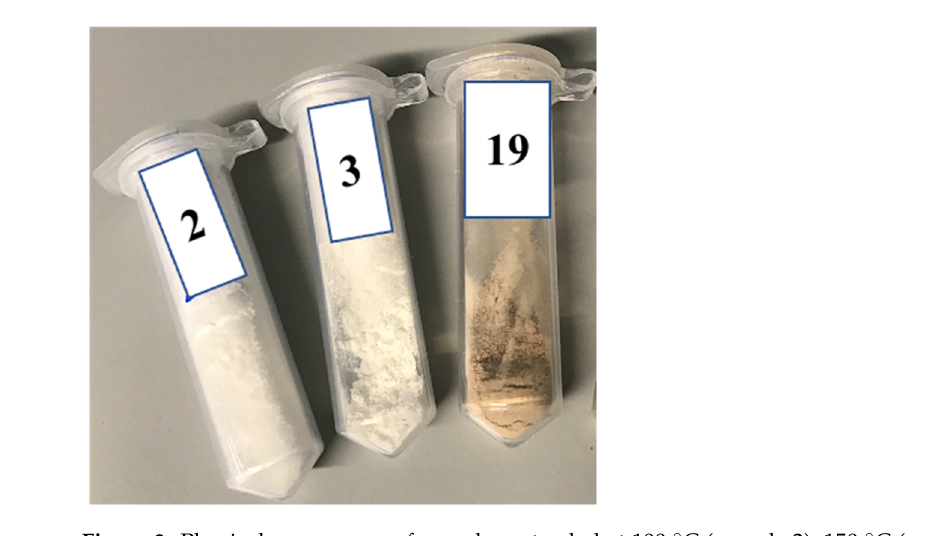
Figure 3. Physical appearance of samples extruded at 100 °C (sample 2), 150 °C (samples 3), and 200 °C (sample 19).